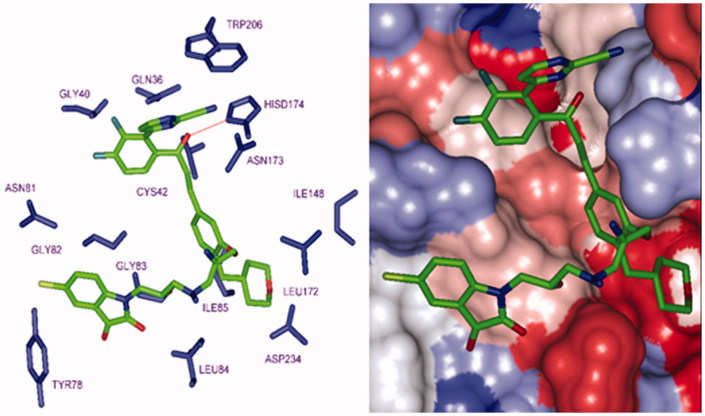
P2 substitution for the S2 pocket filling. (Left): Close up of 125–1-1–H–lki–128 (IC
50
pre = 13 nM) at the FP-2 active site. Carbon atoms of interacting residue side chains are coloured blue and those of ligand in green. (Right): Connolly surface of the FP-2 active site for 125–1-1–H–lki–128. The binding site surface is coloured according to residue hydrophobicity: red – hydrophobic, blue – hydrophilic and white – intermediate.